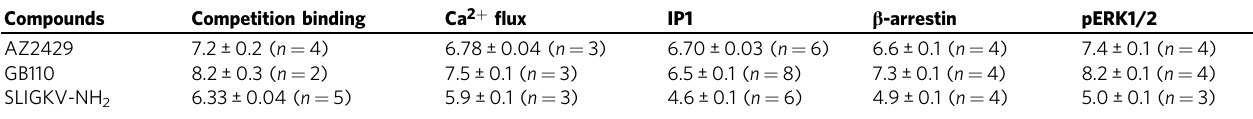
IP1 and Ca 2 + were assessed in 1321N1-hPAR2 cells, β -arrestin-2 and pERK1/2 in U2OS-hPAR2, binding was measured in membranes from HEKexpi293F cells. Data are presented as mean pKi (binding only) or pEC 50 ±s.e.m. based on n independent